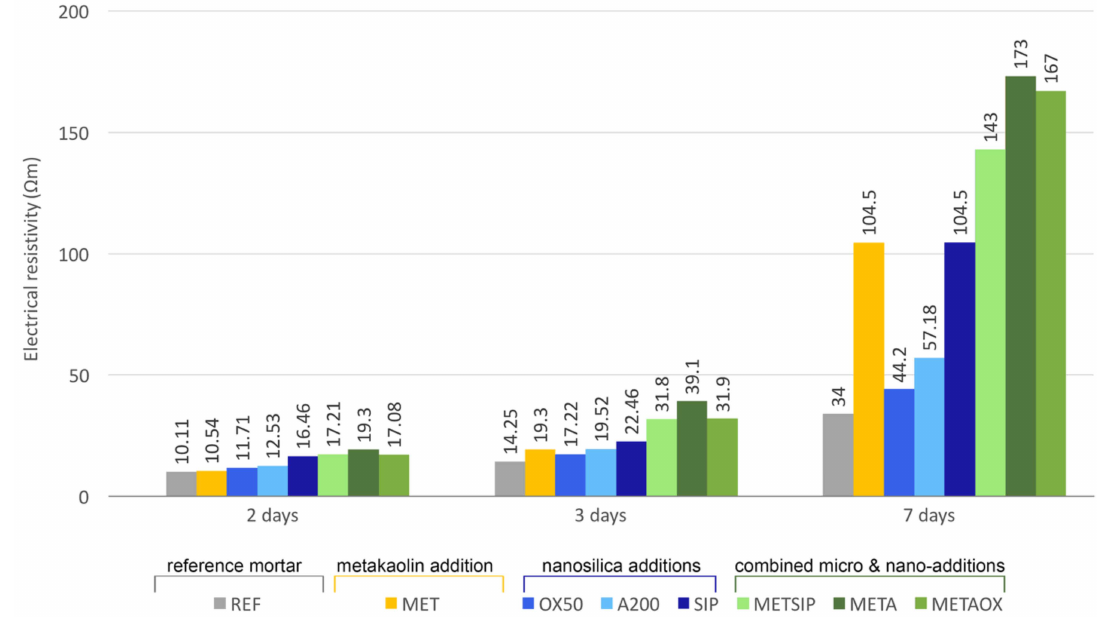
Figure 2. Evolution of electrical resistivity at early